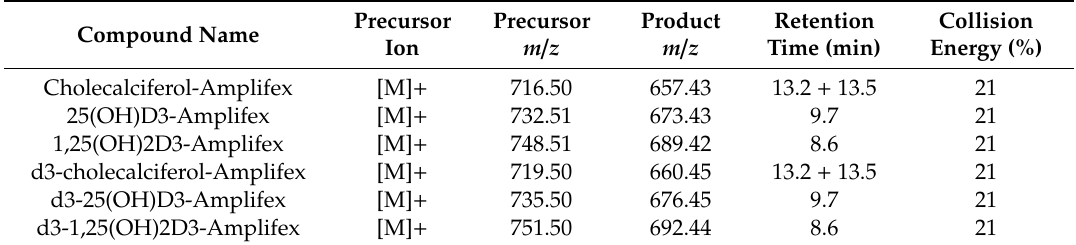
Precursor and product ions m / z values, retention times, and normalized collision energies for Amplifex-derivatized cholecalciferol, 25(OH)D3, 1,25(OH)2D3, and the corresponding isotopically-labeled molecule for absolute